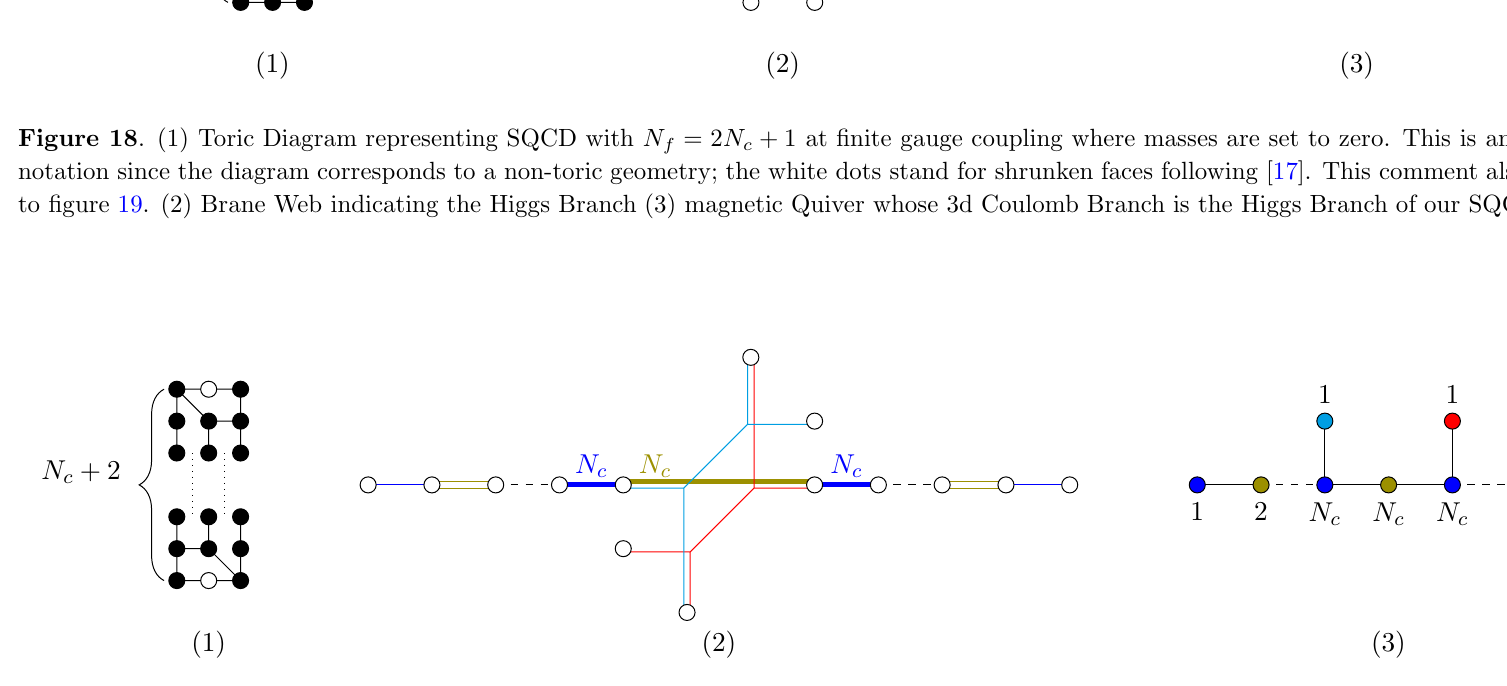
Figure 19 . (1) Toric Diagram representing SQCD with N f = 2 N c + 2 at finite gauge coupling where masses are set to zero. (2) Brane Web indicating the Higgs Branch (3) magnetic Quiver whose 3d Coulomb Branch is the Higgs Branch of our